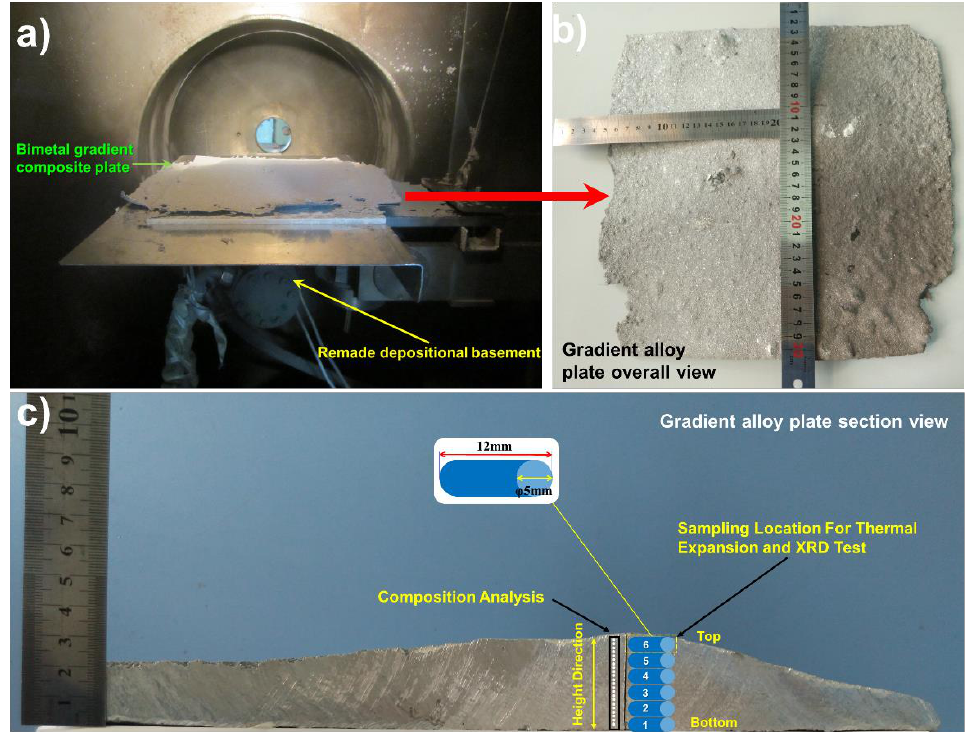
Figure 3. Bimetallic gradient composite plate and sampling location: ( a ) bimetallic gradient composite plate and depositional basement, ( b ) gradient alloy plate overall view, ( c ) section view and the sampling location for the test.